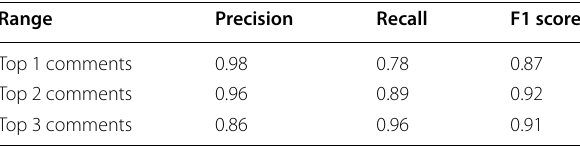
Table 2 Statistics for selecting